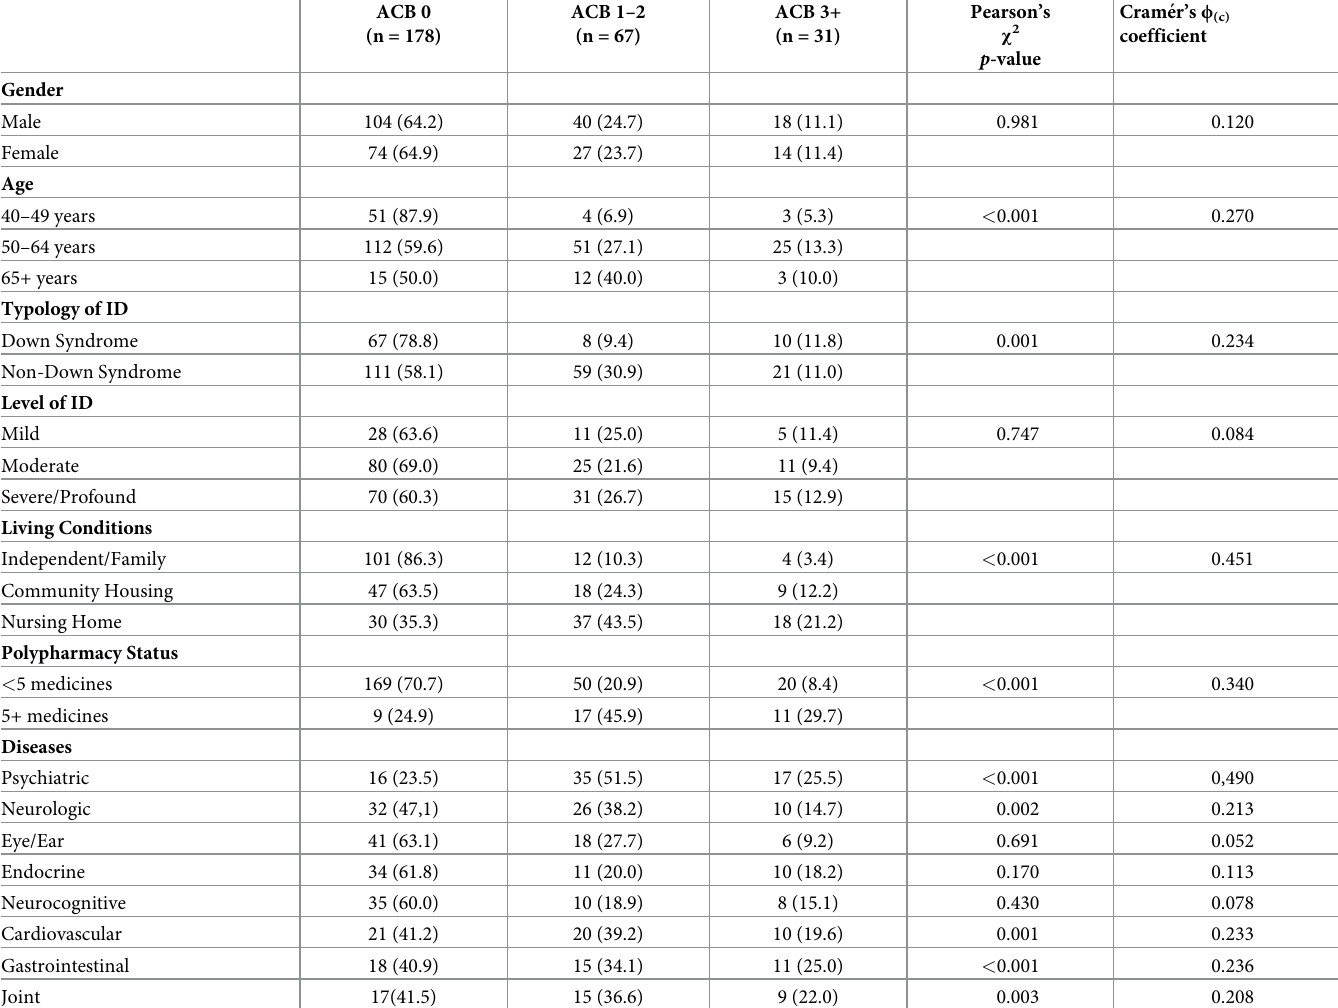
Table 2. Demographic, clinical and social characteristics by ACB score